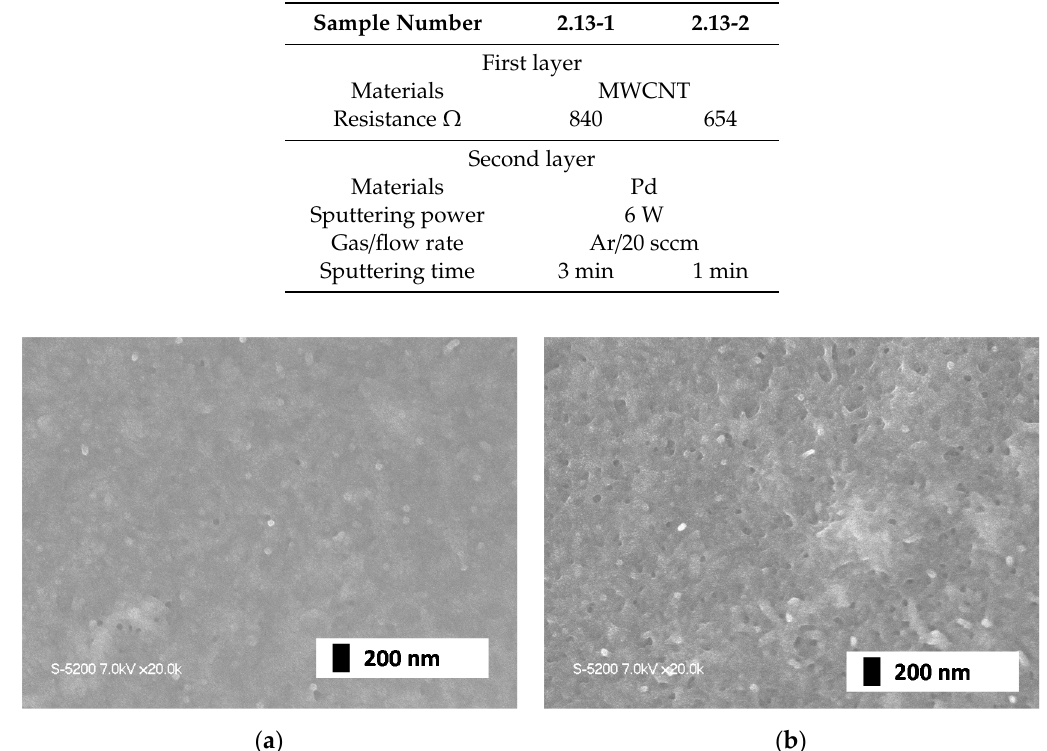
Figure 1. Surface morphologies. ( a ) SEM image of Sample 2.13-1( b ) SEM image of Sample 2.13-2